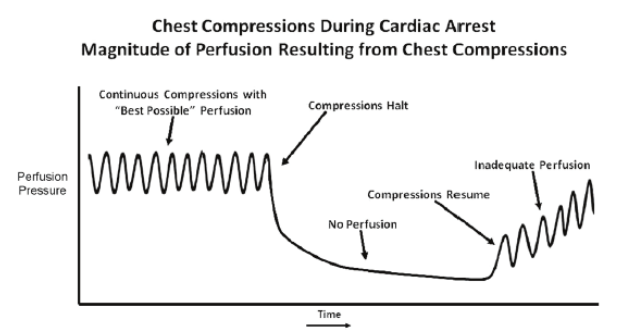
Figure 2: Prolonged interruptions in chest compressions lead to even greater periods of inadequate perfusion